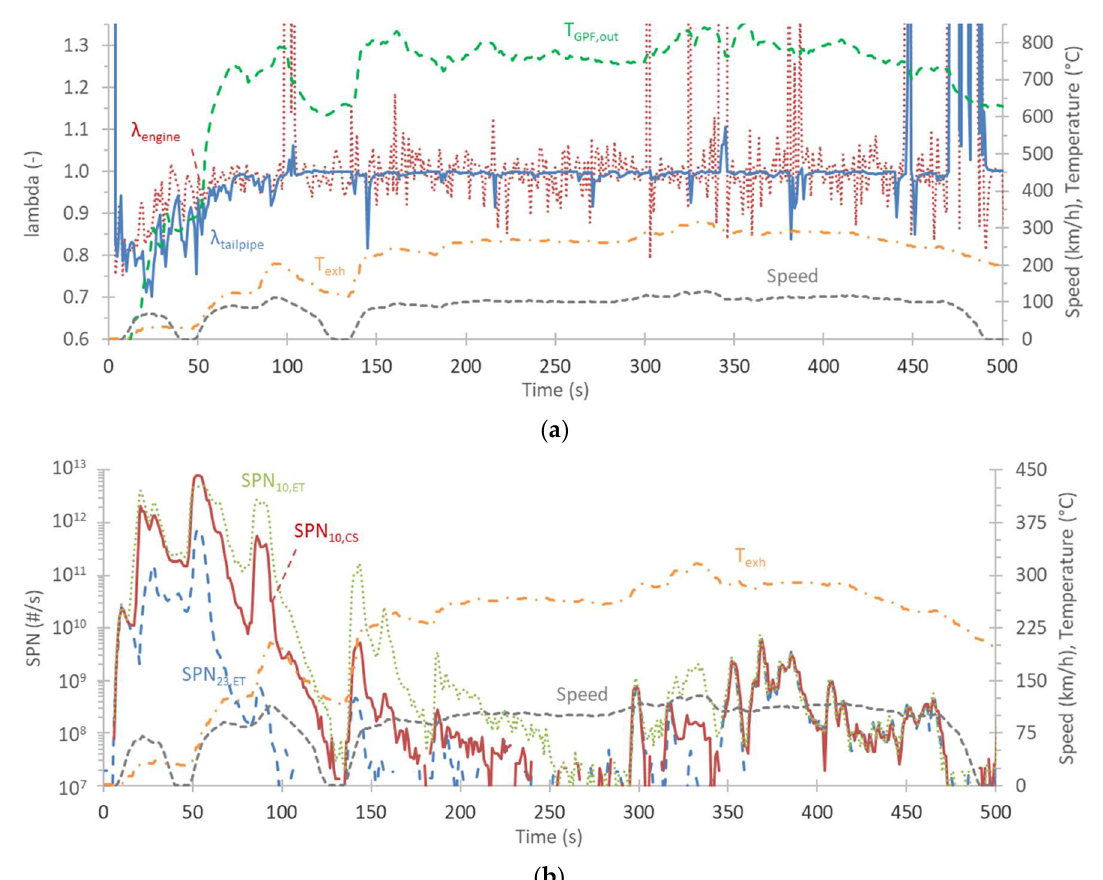
Figure 4. Cold start US06 at −4 °C: ( a ) lambda values at the engine out (engine) and downstream of the GPF (tailpipe). The speed profile and the exhaust gas temperature at the GPF (gasoline particulate filter) outlet and tailpipe (exh) are also given; ( b ) solid particle number emissions >23 nm (SPN 23 ) and 10 nm (SPN 10 ), downstream of an evaporation tube (ET) or a catalytic stripper (CS). The speed profile and the exhaust gas temperature at the tailpipe outlet are also given.